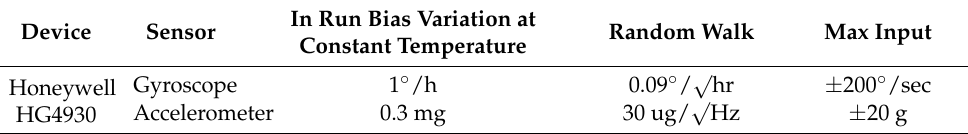
Table 1. Characteristics of the gyroscopes and accelerometers of the Honeywell HG4930